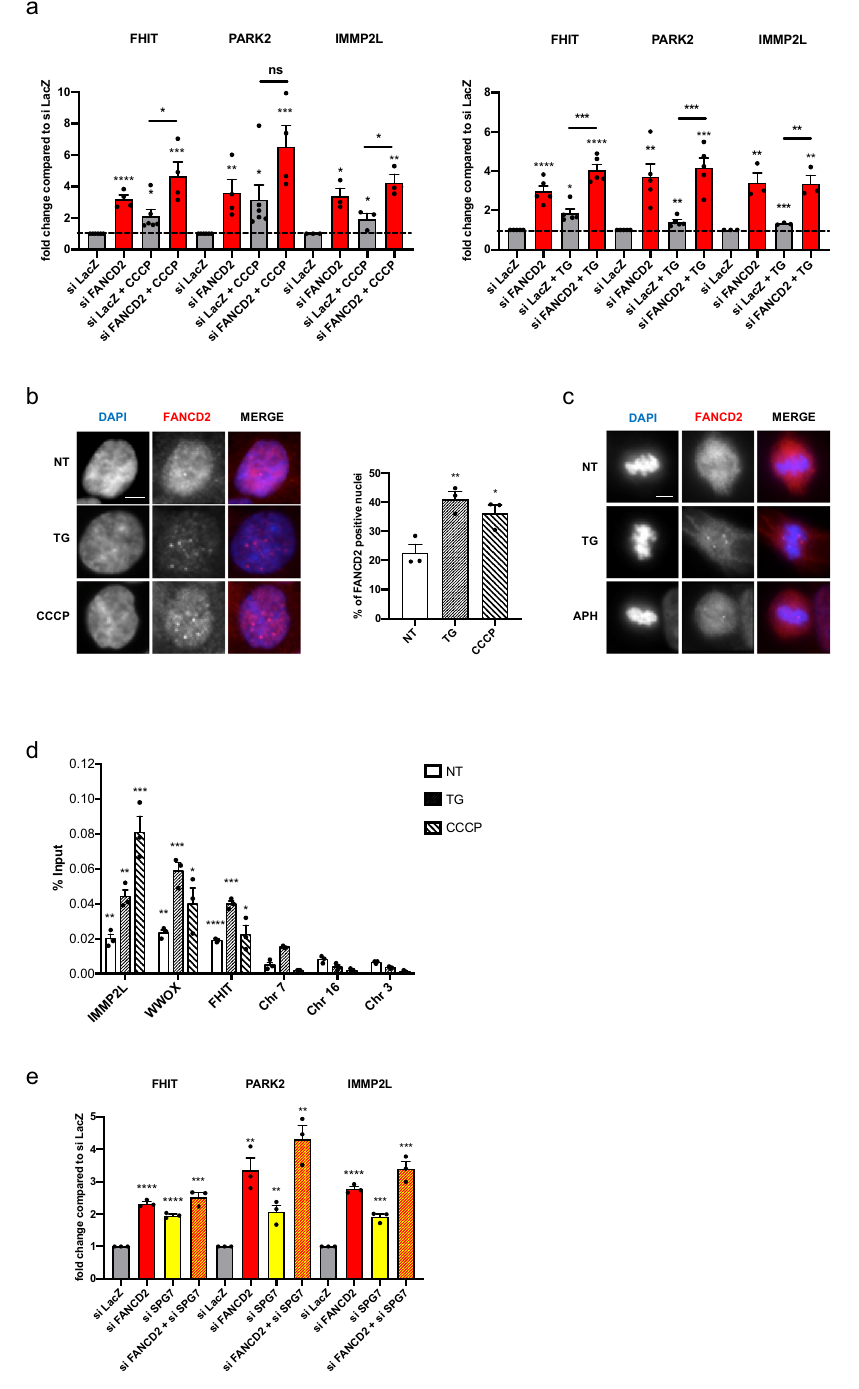
Then, to determine if UBL5 is involved in regulation of CFS genes, we downregulated UBL5 and measured CFS gene expression. UBL5 knockdown signi fi cantly reduced the upregulation of CFS genes in FANCD2-depleted cells in untreated conditions (Fig. 6g), and also partially or completely abrogated their induction after CCCP or TG treatments (Supplementary Fig. 5g, h), revealing that FANCD2 and UBL5 may operate in the same pathway to regulate the mtUPR and CFS stability in human cells. Reducing CFS gene induction by downregulating UBL5 in FANCD2-depleted cells decreased chromosome instability observed after APH treatment to levels similar to control values (Fig. 6h), indicating that suppression COMMUNICATIONS BIOLOGY| (2021) 4:127